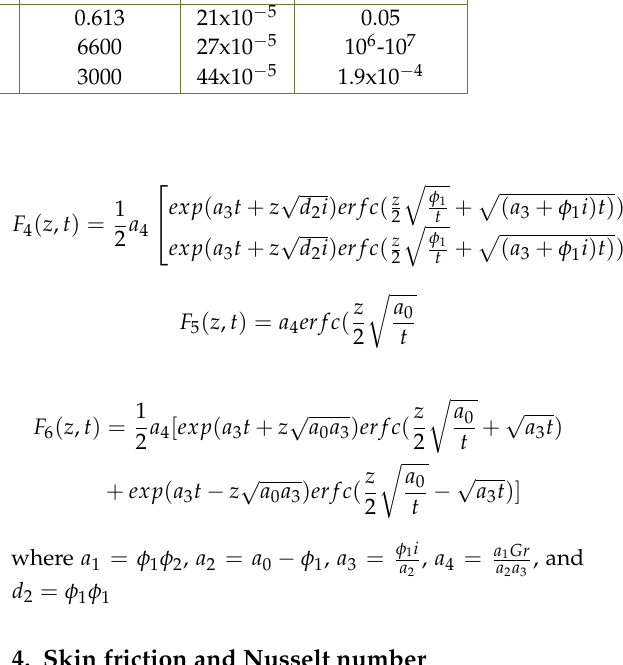
Table 1. Thermophysical properties of water, SWCNTs, and MWCNTs.